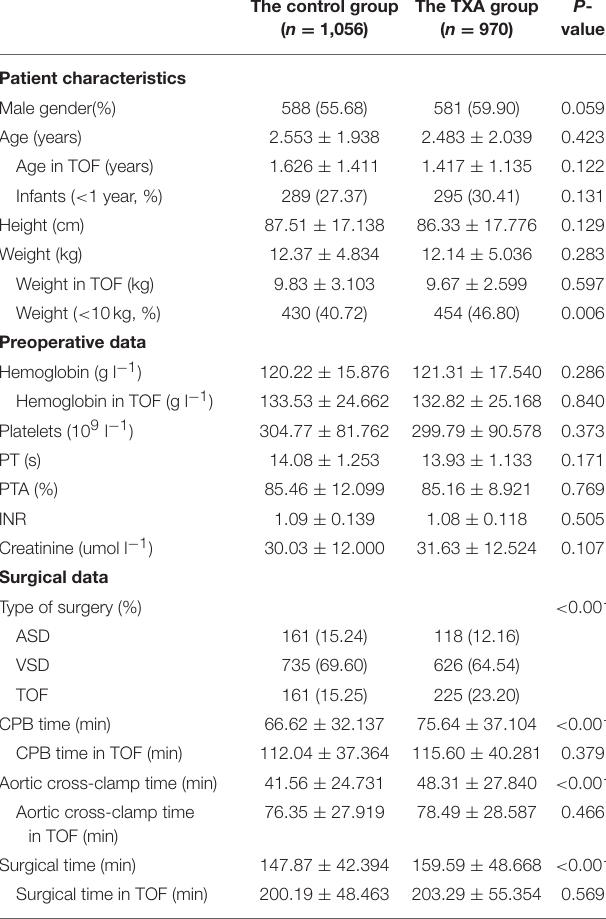
TABLE 1 | Perioperative